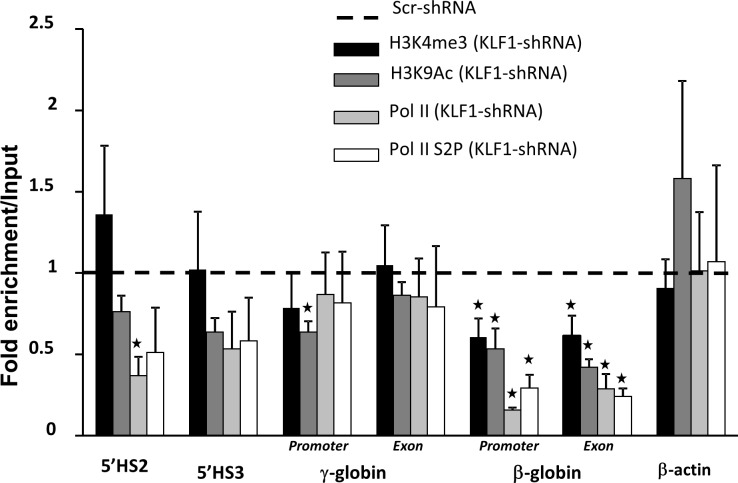
KLF1 knockdown reduces H3K4me3 and RNA polymerase II recruitment at the β- but not γ-globin gene.ChIP assays were performed using anti-H3K9Ac, anti-H3K4me3, anti-RNA Pol II or anti-RNA Pol II S2P antibodies on Scr and KLF1 shRNA-treated UCB erythroblasts. H3K9 acetylation generally indicates open chromatin configuration and H3K4 trimethylation marks regions of active transcription. qPCR was used to quantify enrichment at 5’HS3, 5’HS2 and at sites within the promoter and exon 2 of the γ- and β-globin genes. The primers for the γ-globin promoter and exon collectively measure the Aγ- and Gγ-globin genes. Non-specific antibodies (IgG) were used as a control for antibody specificity. β-actin was used as a control gene not regulated by KLF1. All regions of the globin locus that were tested show significant enrichment for H3K9Ac, H3K4me3, RNA Pol II and RNA Pol II-S2P compared to IgG in normal (Scr-shRNA treated) cells (data not shown). Enrichment in Scr shRNA-treated cells was set to 1 and relative enrichment in KLF1 shRNA-treated cells is shown for each genomic region tested. N = 4, error bars = standard error, * = p-value<0.05 compared to Scr shRNA. Residual KLF1 mRNA = 11–31% in KLF1 shRNA-treated samples.